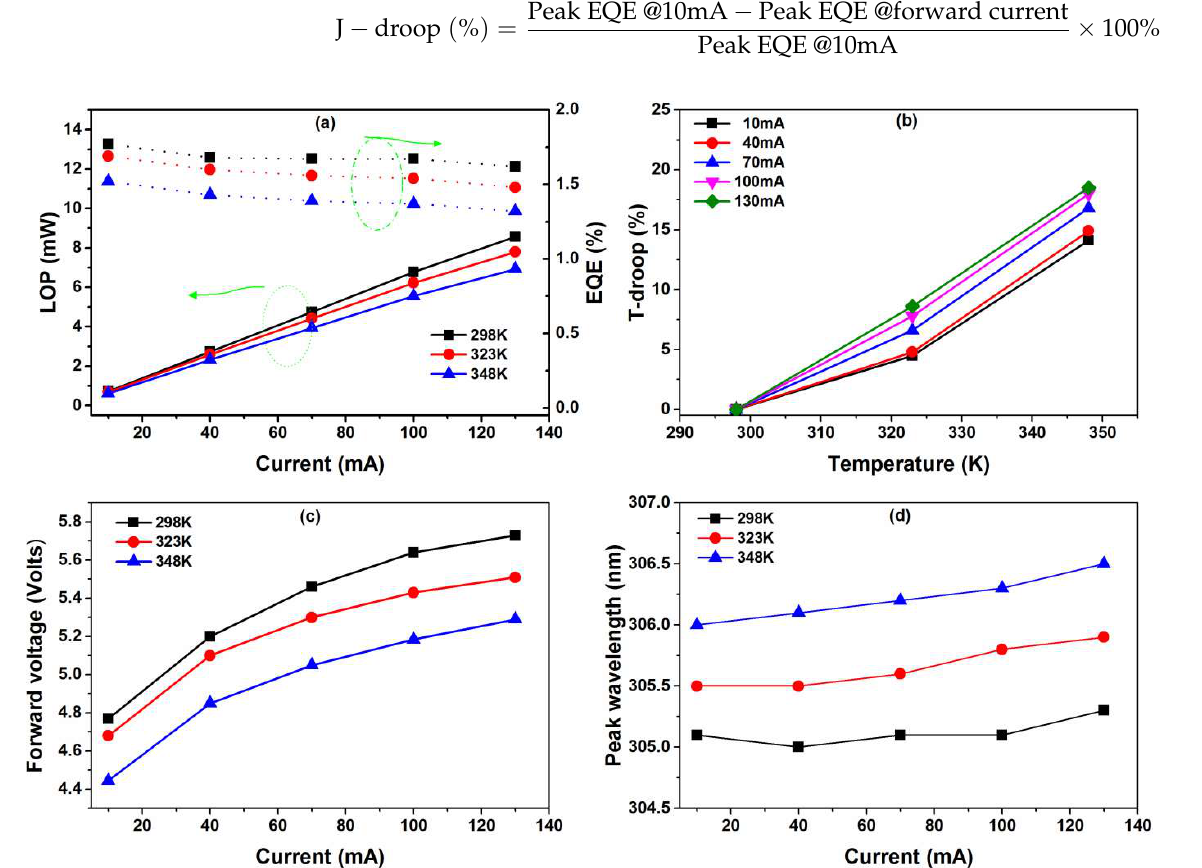
Figure 1. ( a ) EQEs (dotted lines) and LOPs (solid lines) of the AlGaN-based UVB-LED plotted with respect to the forward current, measured at three different temperatures. ( b ) T-droop plotted with respect to temperature, measured at various forward currents. ( c ) Forward voltage and ( d ) peak wavelength plotted with respect to forward current, measured at the three temperatures.